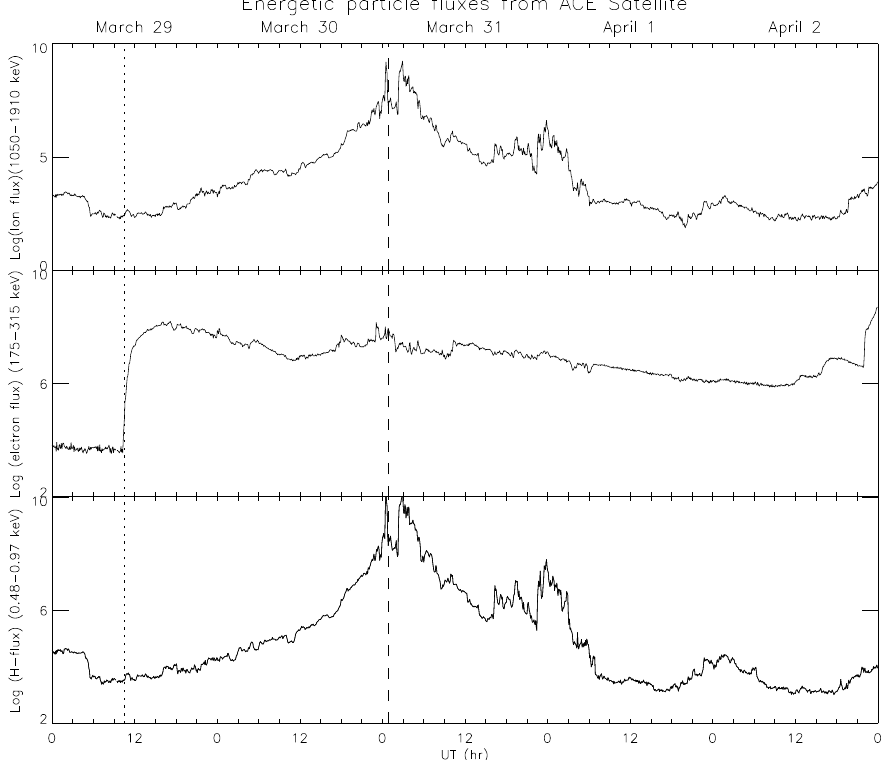
Fig. 9. The interplanetary data obtained from the ACE satellite. The ACE satellite was upstream of the Earth at a GSM position of (x=1.4 × 10 6 km, y=1.2 × 10 5 km, z= − 2.0 × 10 5 km). From top to bottom, each panel presents the energetic ion flux, electron flux and hydrogen